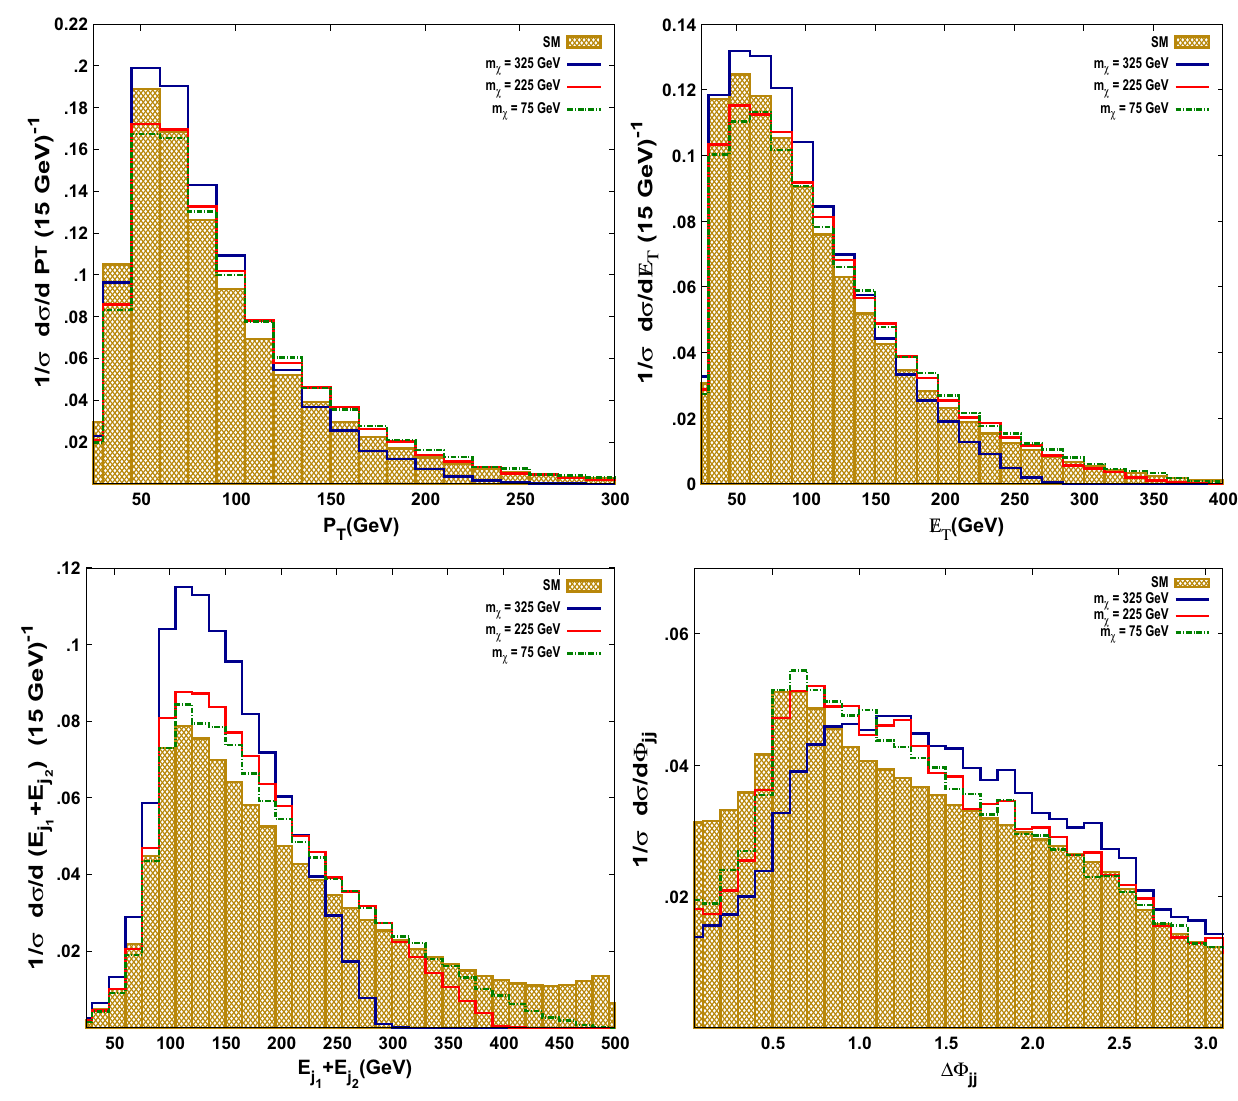
√ s = 1 TeV, Λ =1 TeV and values of M χ = 75 and 325 GeV at α l = α l = α l = α l = 1. The bin width is 0.1 for the Δφ VV AA V A AV